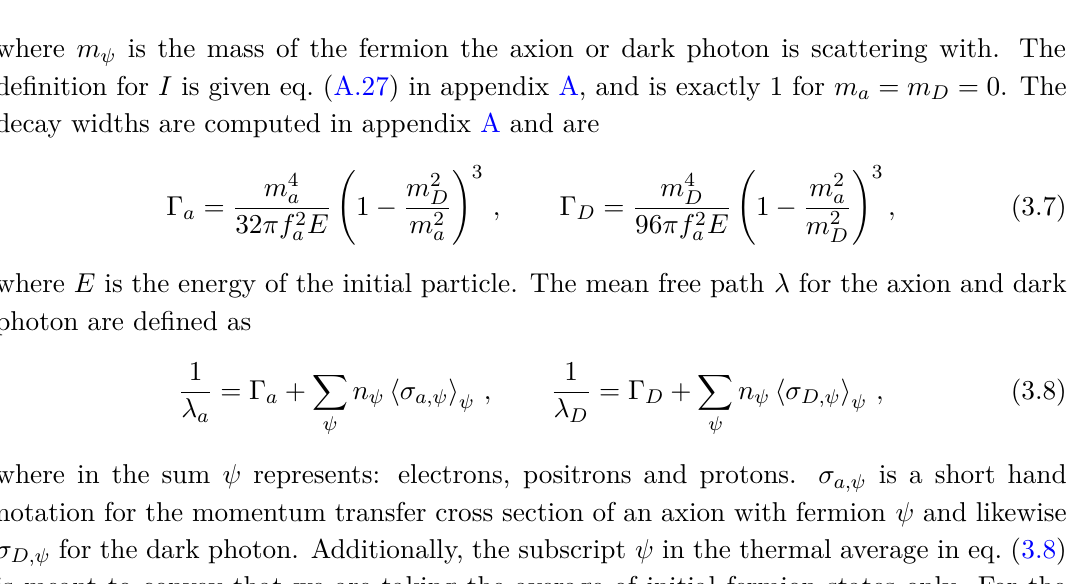
Figure 4 . The diagrams for the dark photon’s scattering off of fermions and its decay into an axion and photon. ψ represents any of the electrically charged fermions in the supernova: electrons, positrons, and protons. The diagrams for axion’s scattering from fermions and its decay are identical to this but with the axion and dark photon exchanged. These diagram are used to compute the momentum transfer cross sections for the various scattering processes and the decay width for the axion and dark photon. These cross sections are then used to place a trapping constraint on the coupling 1 /f a